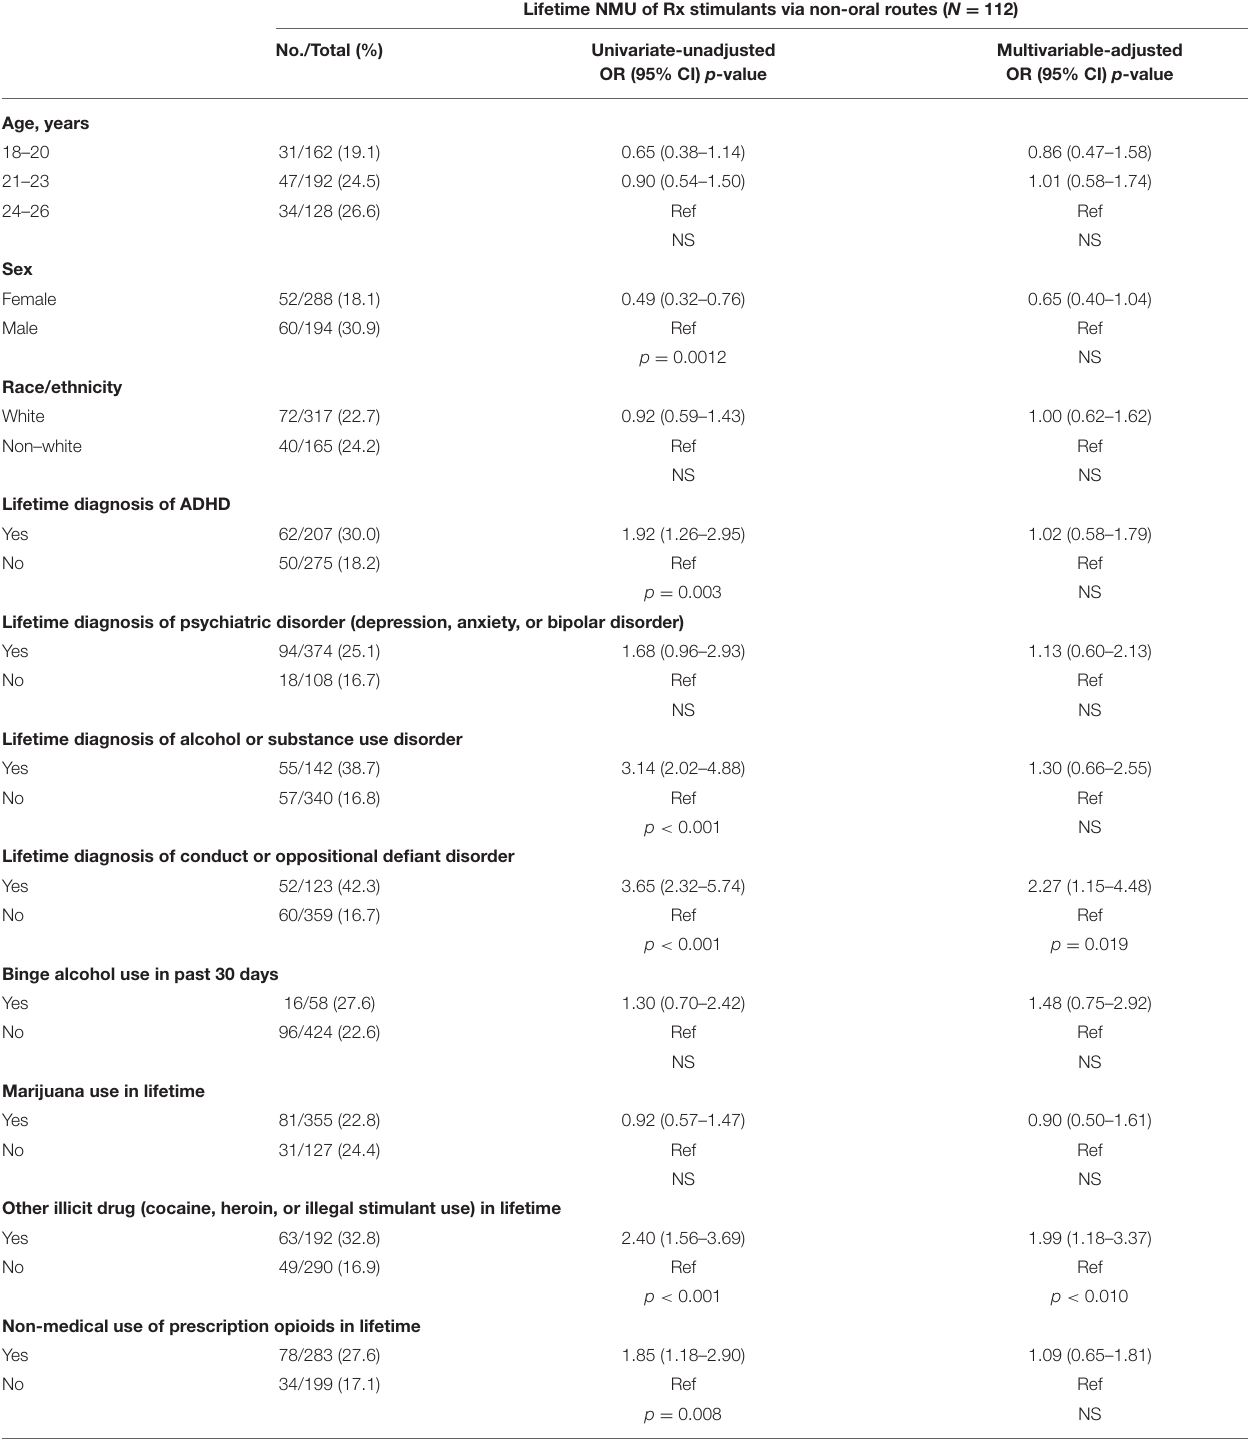
TABLE 2 | Factors associated with lifetime non-medical use of prescription stimulants via non-oral routes* compared with oral routes only among college students ( N =